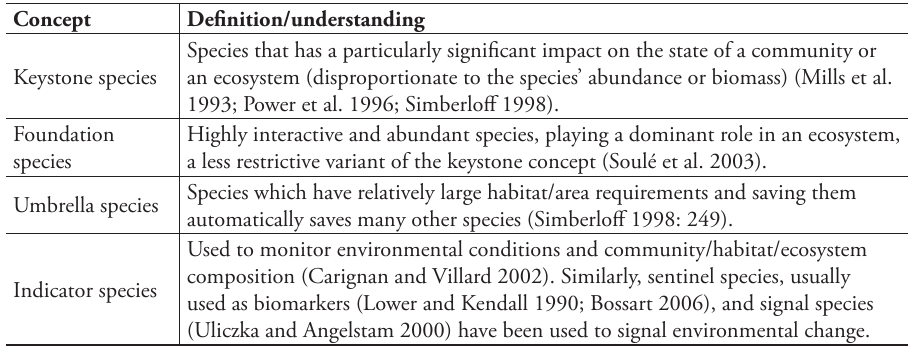
Table 1. Concepts focusing on the special ecological importance of a species.